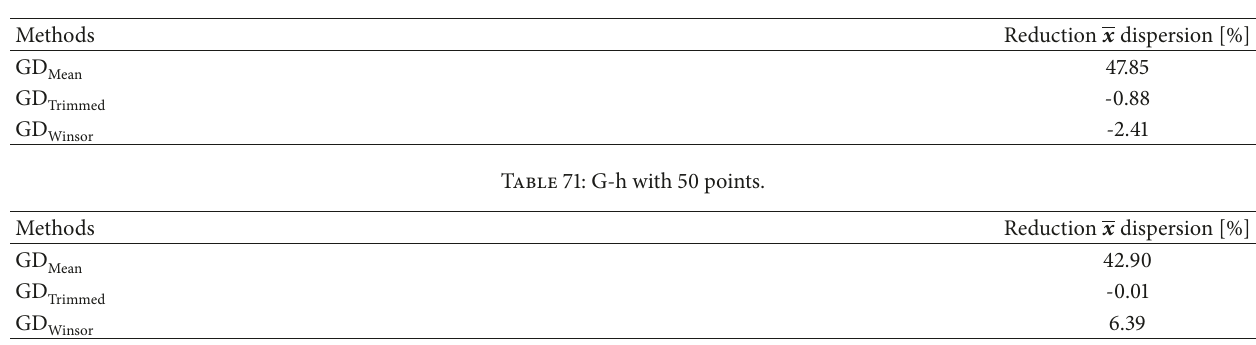
Table 70: G-h with 20 points.